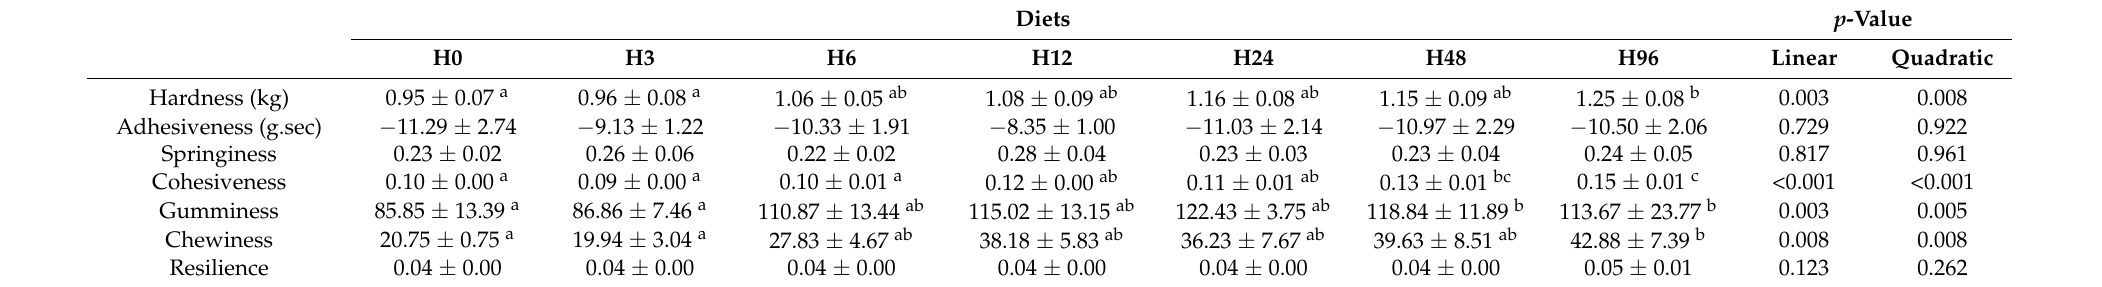
Table 8. Effect of dietary histamine content on the dorsal muscle texture of the hybrid grouper.